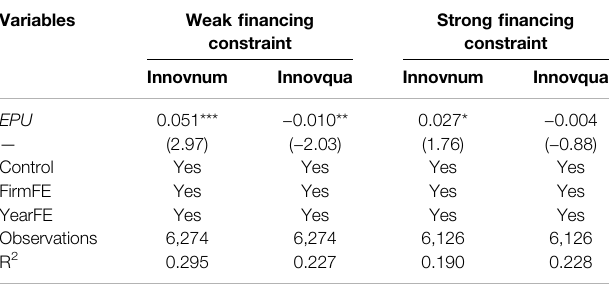
TABLE 6 | Heterogeneity of fi rm fi nancing constraints. Variables